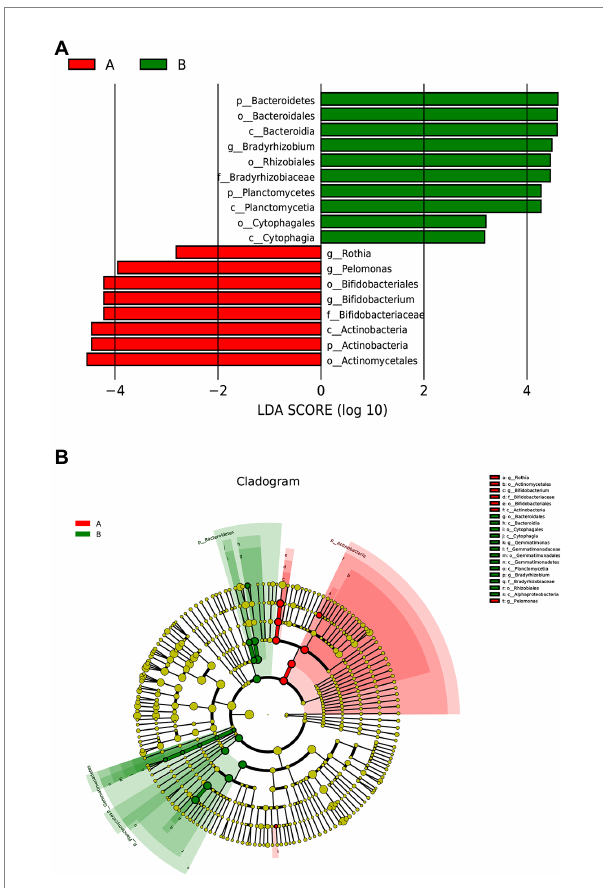
FIGURE 3 Lefse analysis between the two groups. (A) Histogram of LDA scores, showing significant differences in microbe type and abundance. LDA scores on the log 10 scale are indicated at the bottom. (B) Cladogram generated by